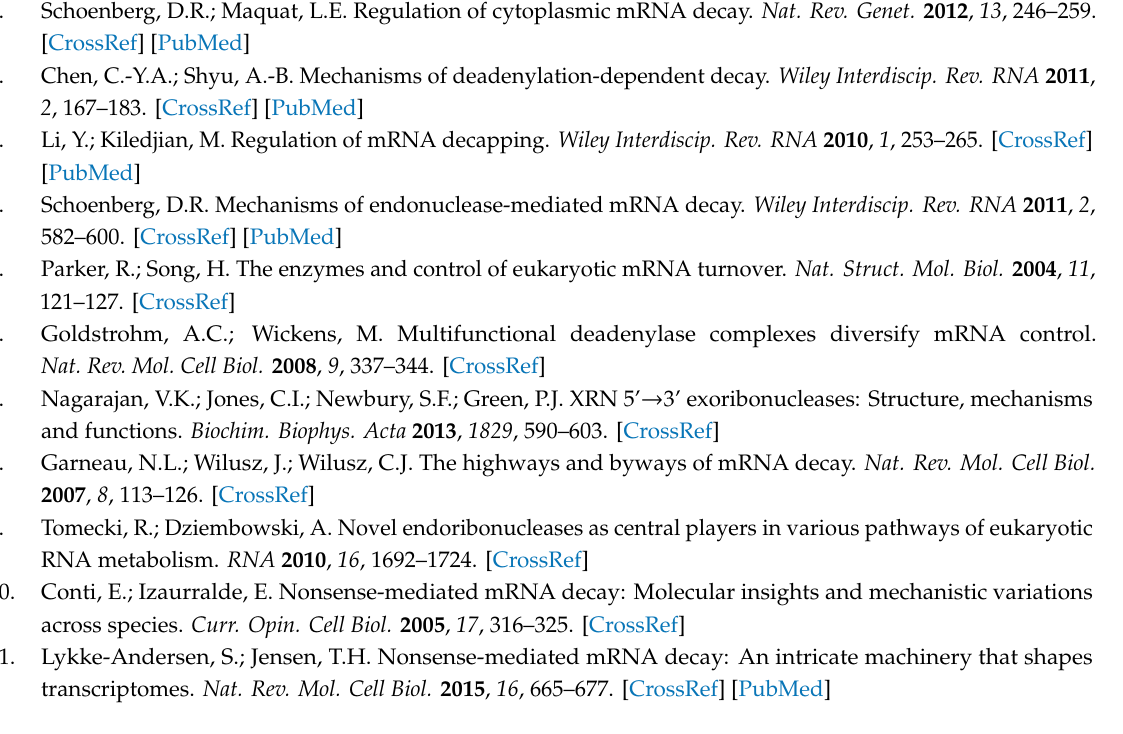
6452 / s1. Table S1. List of stable and unstable candidate transcripts. Table S2. List of endonucleolytic cleaved candidate transcripts. Table S3. List of decapped candidate